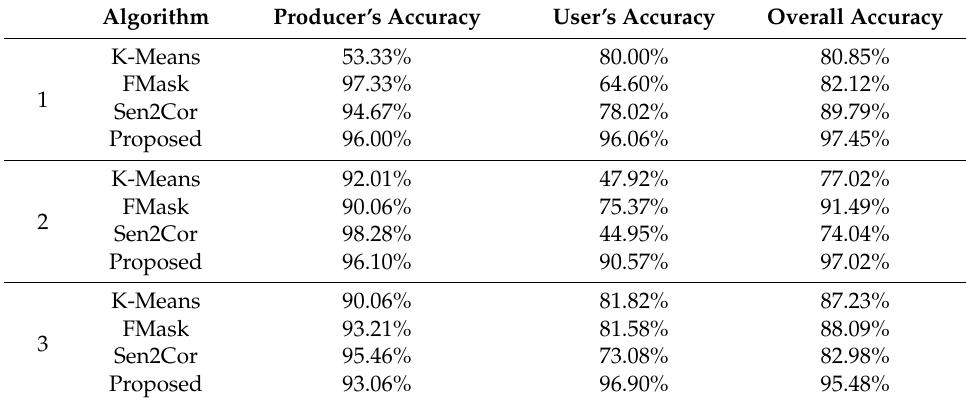
Table 1. Producer’s accuracy, user’s accuracy, and overall accuracy using the classic methods versus proposed